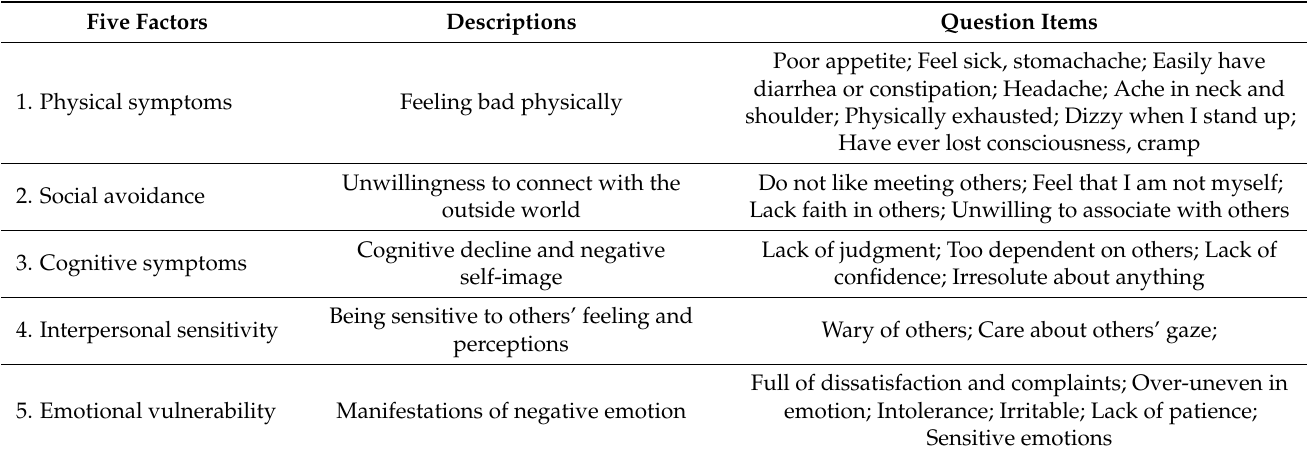
Table 1. Five factors in revised UPI tailored to Chinese students.